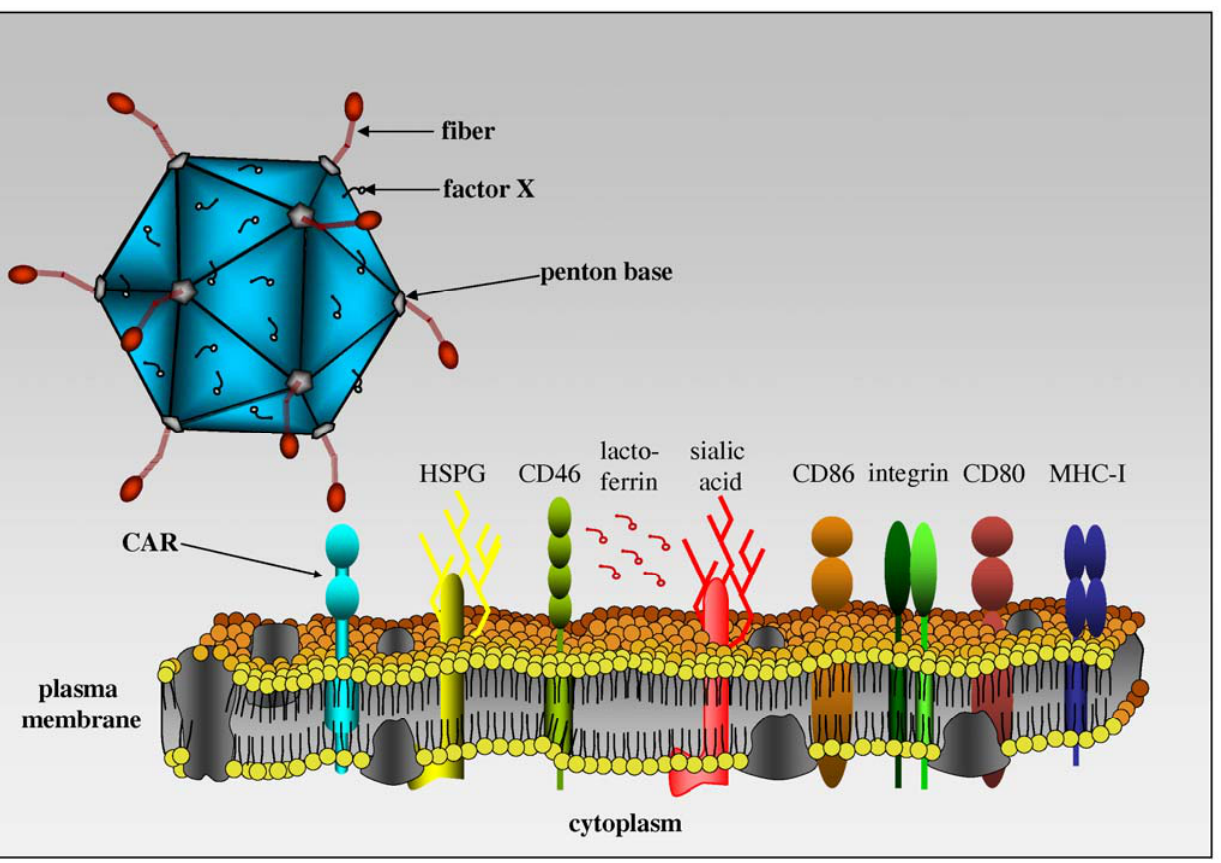
Figure 3. An overview of molecules involved in adenovirus binding. Adenoviruses can attach to CAR, sialic acid, CD46, CD86, CD80, MHC-I and heparin sulfate proteoglycan (HSPG) depending on the serotype. Some HAds also use coagulation factors and lactoferrin as bridges to attach to cells. To the best of our knowledge, CAR is the only receptor for CAV-2. (Image modified from Kremer, Blood